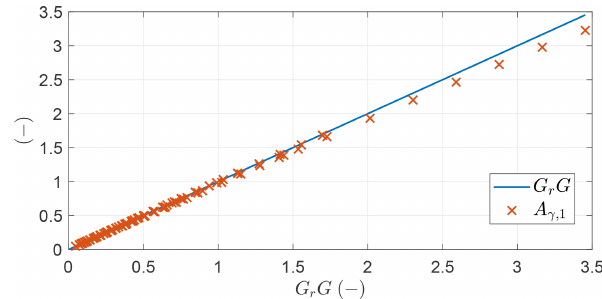
Figure 14. Amplitude of the first Fourier coefficient of γ (x) found by solving multiple OCPs and analytical approximation (–) as a function of G r G